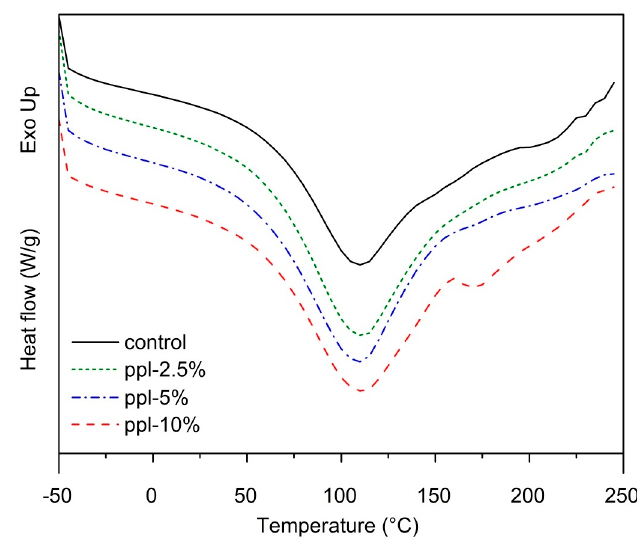
Figure 6. DSC thermographs of the developed films.